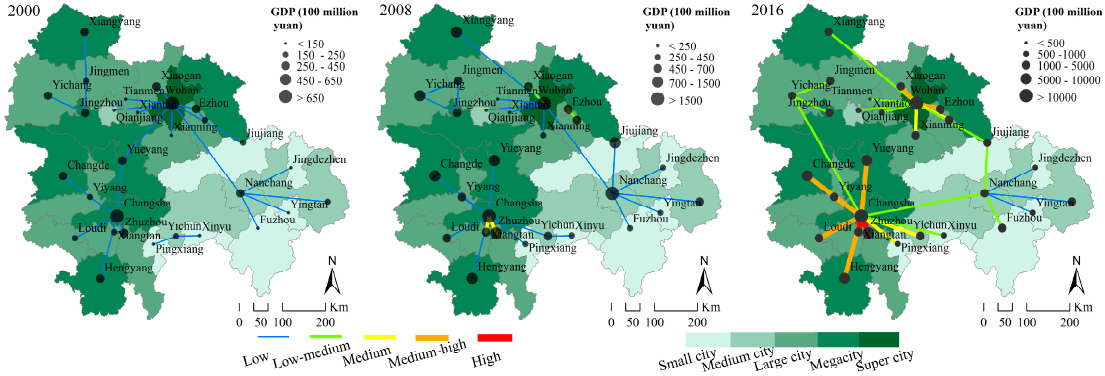
Figure 13. The interactions among the cities within the MYRB by the gravity model.